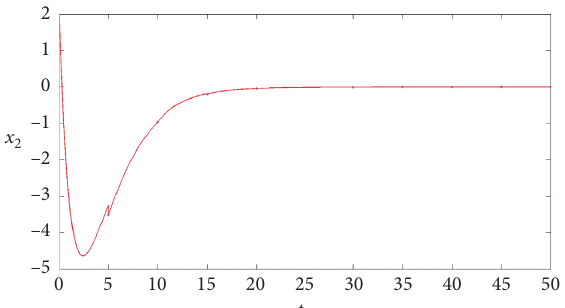
Figure 4: The trajectory of the state x to the initial condition x ( 0 ) � (− 6 ,, 2 ) T and the resetting time � 5 k, k � 1 , 2 , ... , t k